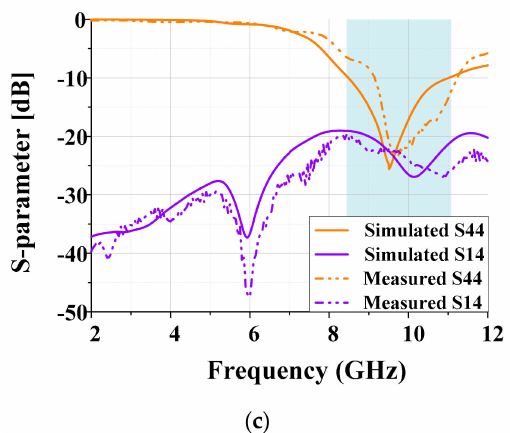
Figure 16. Measured and simulated S-parameters of NB antennas: ( a ) NB Antenna #1, ( b ) NB Antenna #2 and ( c ) NB Antenna